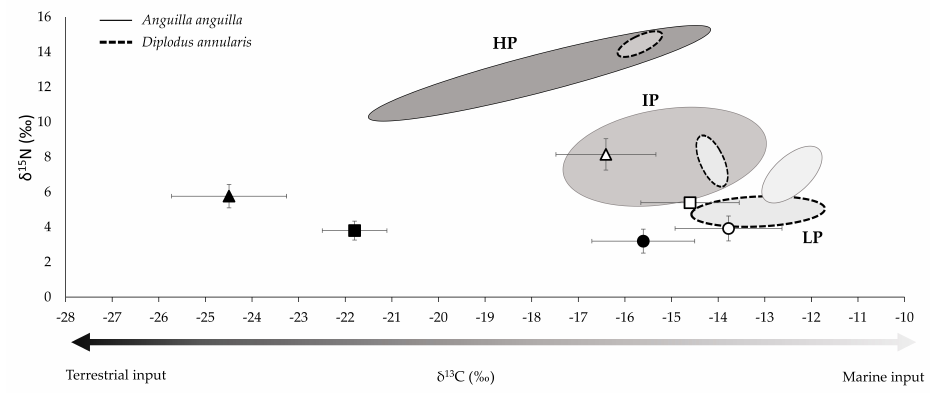
Figure 2. Isotopic standard ellipse areas (SEAcs) of Anguilla anguilla (continuous line) and Diplodus annularis (dashed line) in lakes with low (LP), intermediate (IP) and high (HP) eutrophication. Isotopic signatures (Mean ± s.e.) of primary producers (empty symbols) and detritus (full symbols) in lakes with low (circle), intermediate (square) and high (triangle) eutrophication. The greyscale reflects the origin of the main organic matter inputs from terrestrial (dark grey, left), to marine (light grey, right).